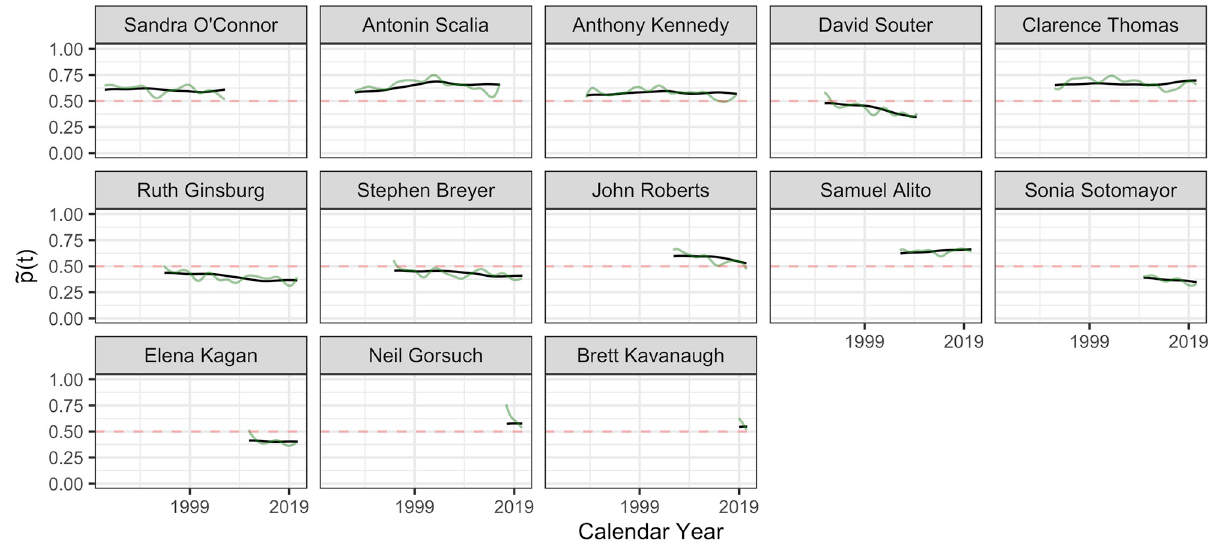
Fig 9. The inferred latent ideology processes ~ p Latent ideology processes ~ p